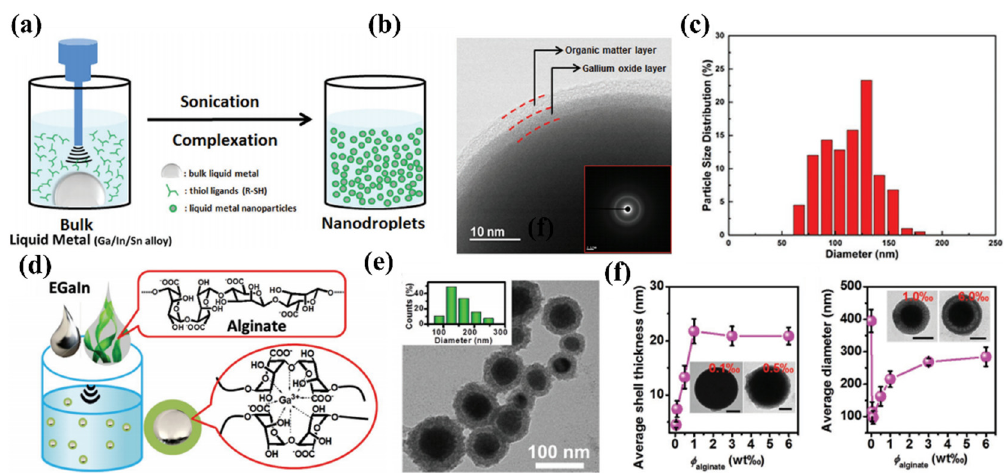
Figure 4. ( a ) Schematic illustration of the preparation route for EGaInSn nanodroplets ( b ) HRTEM image demonstrates the core–shell structure of EGaInSn nanodroplets, the inset is the corresponding SAED pattern ( c ) Size distribution of EGaInSn nanodroplets. Reprinted with permission from Ref. [69] Copyright 2016 Advanced functional materials. ( d ) Production of aqueous ink of EGaIn nanodroplets using alginate microgel as the solution ( e ) TEM image and diameter histogram of EGaIn nanodroplets ( f ) average shell thickness and average diameter of EGaIn droplets on alginate concentration. Reprinted with permission from Ref. [67] Copyright 2018 Advanced functional